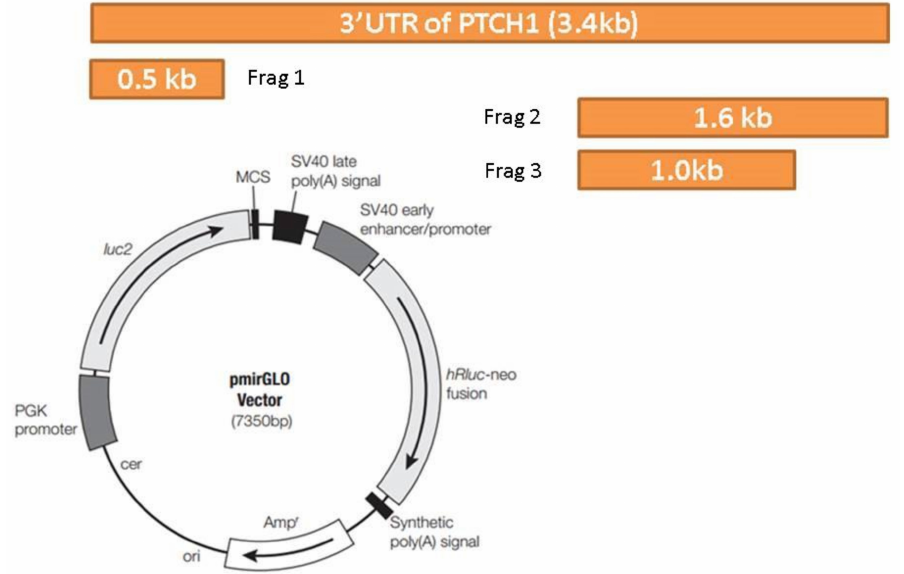
Figure 20. PTCH1 3 (cid:48) untranslated region (3 (cid:48) UTR) luciferase vector design. The overall PTCH1 3 (cid:48) UTR luciferase vector design is shown above. One full-length PTCH1 3 (cid:48) UTR and three different truncated versions of PTCH1 were constructed and then cloned into vector pmirGLO.